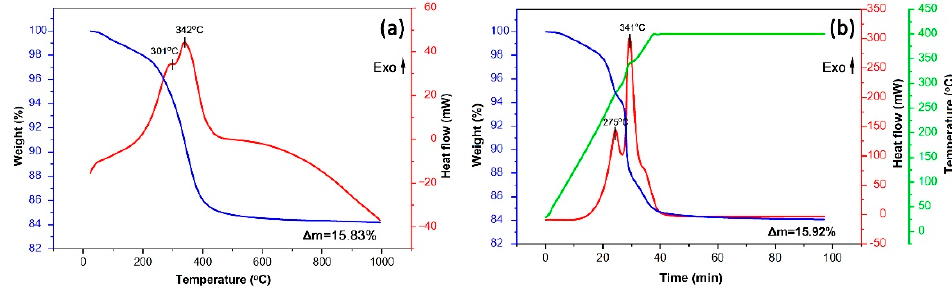
Figure 2. Thermal analysis results (weight—blue curve; heat flow—red curve; temperature—green curve) for the semiproduct in the temperature range of 25–1000 °C ( a ) and in the range of 25–400 °C with exposure to 400 °C for 1 h ( b ).